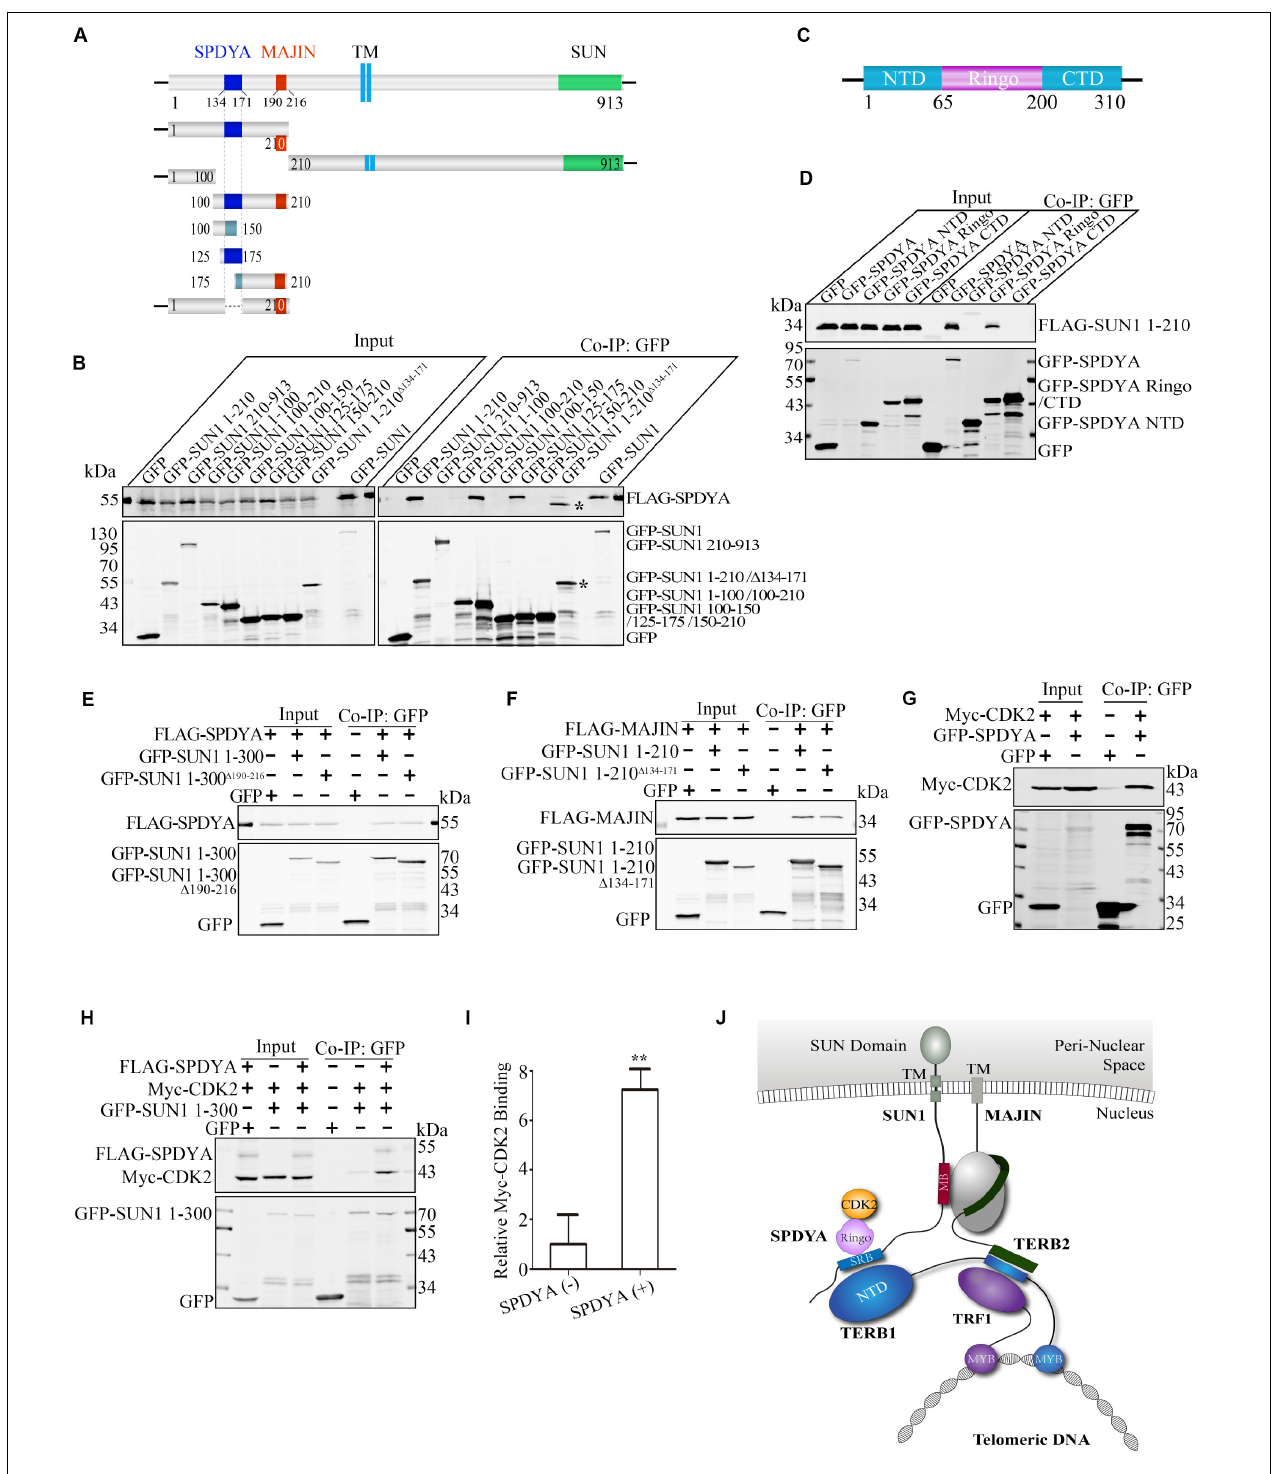
FIGURE 5 | SPDYA recruits CDK2 to SUN1. (A) Illustration of the SPDYA-binding site at SUN1. The SPDYA-binding site is shown in dark blue. TM: trans-membrane region. (B) The 134–171 Aa of SUN1 in the SPDYA binding site. *Indicating the band of GFP-SUN1 1–210 Aa (cid:49) 134 - 171 . (C) Illustration of the SPDYA structure. (D) The Ringo domain of SPDYA is the binding site of SUN1. (E) The interaction of SUN1 mutant with MAJIN-binding site deletion between SPDYA. (F) The interaction of SUN1 mutant with SPDYA-binding site deletion between MAJIN. (G,H) SPDYA interacts with CDK2 and recruits CDK2 to SUN1. (I) The histogram shows Myc-CDK2 binding in (H) , data are presented as mean ± SEM with three repeats. ** P < 0.01. (J) Illustration of the interaction of SUN1 with MAJIN and SPDYA-CDK2. The SPDYA Ringo domain binding site of SUN1 is shown in blue and name “SRB.”